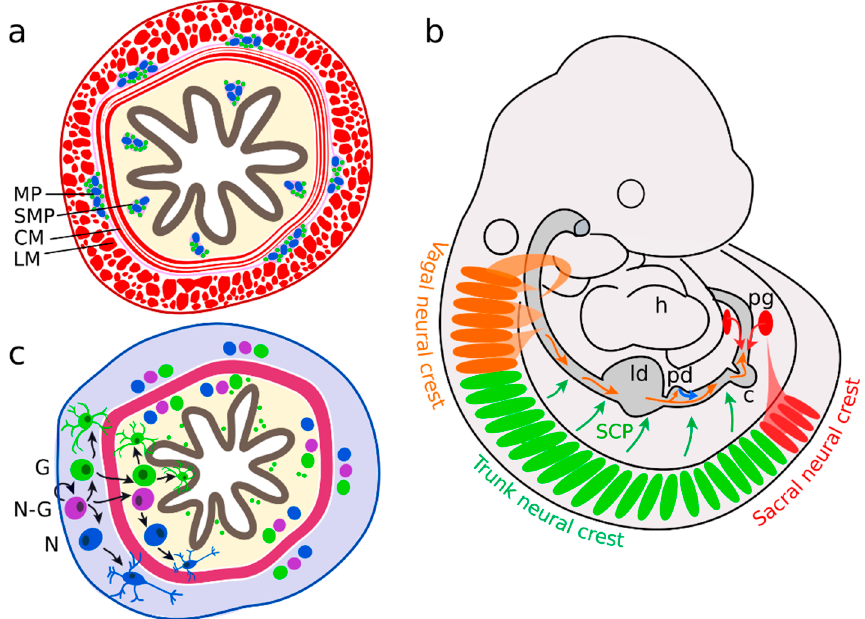
Figure 1. Enteric nervous system (ENS) precursors colonize the gut in two waves. ( a ) Enteric ganglia form the myenteric plexus (MP) between the circular (CM) and longitudinal muscle (LM) layers and the submucosal plexus (SMP) in the mucosa. ( b ) The majority of neural precursors are derived from the vagal neural crest, adjacent to somites 1 to 7 (orange). They migrate along the bowel in an oral to anal direction. A second group originates from sacral neural crest cells (in mice behind somite 24), forms the pelvic ganglia (pg) and migrates in an anal to oral direction (red). Further enteric neural precursors are descendants of Schwann cell precursors (SCP, green) or pancreatic progenitors (blue). ( c ) Neural-fated enteric neural crest-derived cells (ENCCs) (N) differentiate in the myenteric region (grey). In parallel, neuron-glia bipotent (N-G) and glial-fated ENCCs (G) migrate into the mucosal area (yellow) and differentiate further into neurons and glial cells.; h heart; ld liver diverticulum, pd pancreatic diverticulum, c caecum.